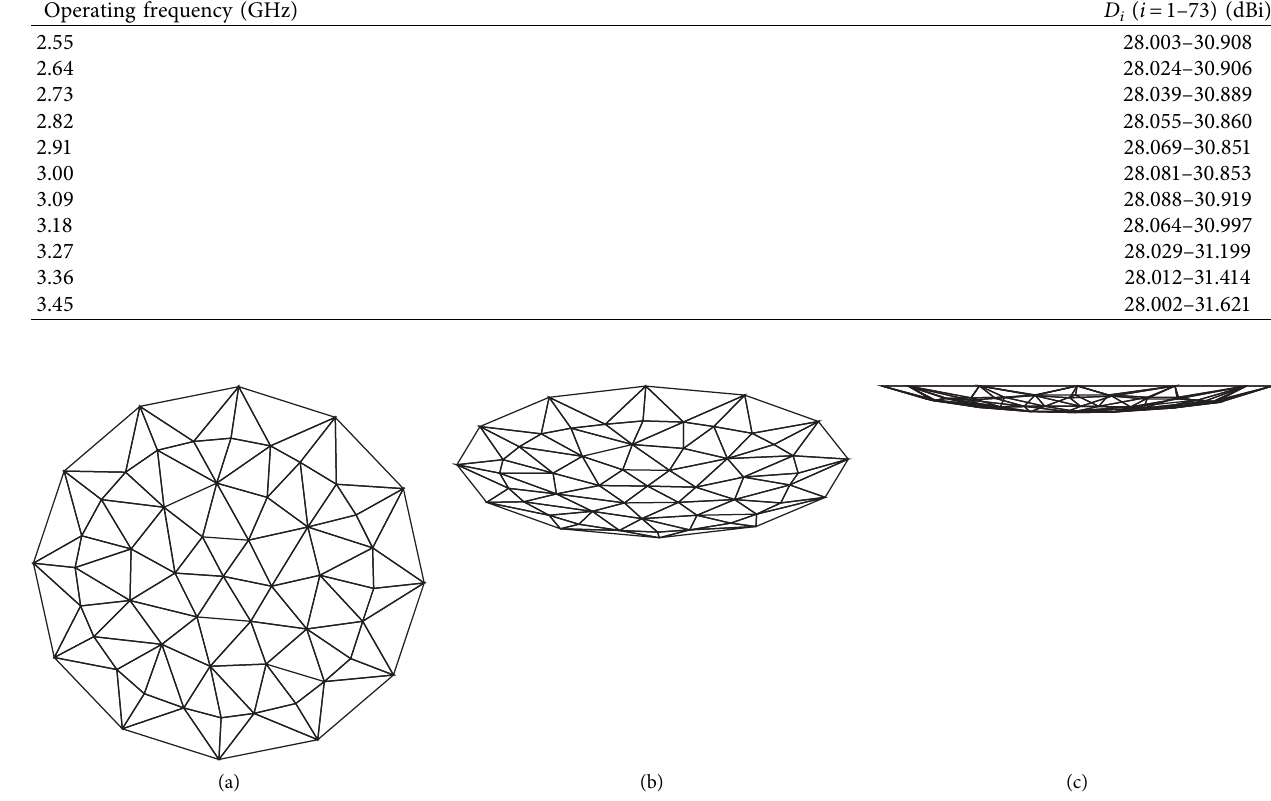
Figure 7: The obtained mesh-shaped reflector. (a) Top view. (b) Isometric view. (c) Side